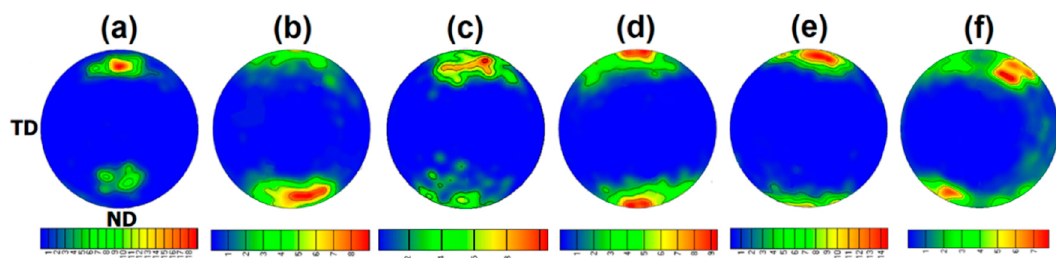
Figure 5. {0001} pole figure maps of TM10 Mg alloys: ( a ) TM10-1P, ( b ) TM10-2P, ( c ) TM10-3P, ( d ) TM10-4P, ( e ) TM10-5P, and ( f ) TM10-6P. The images are taken normal to the RD.